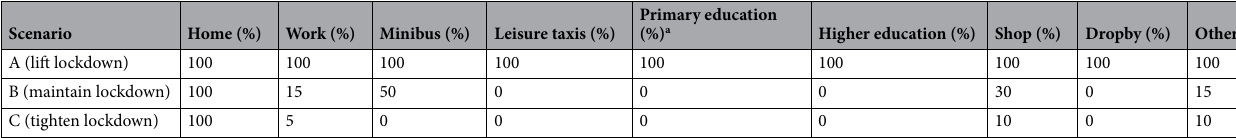
Table 1. Simulation setups including the allowed share of an activity type of all activity types after a certain lockdown. a Including